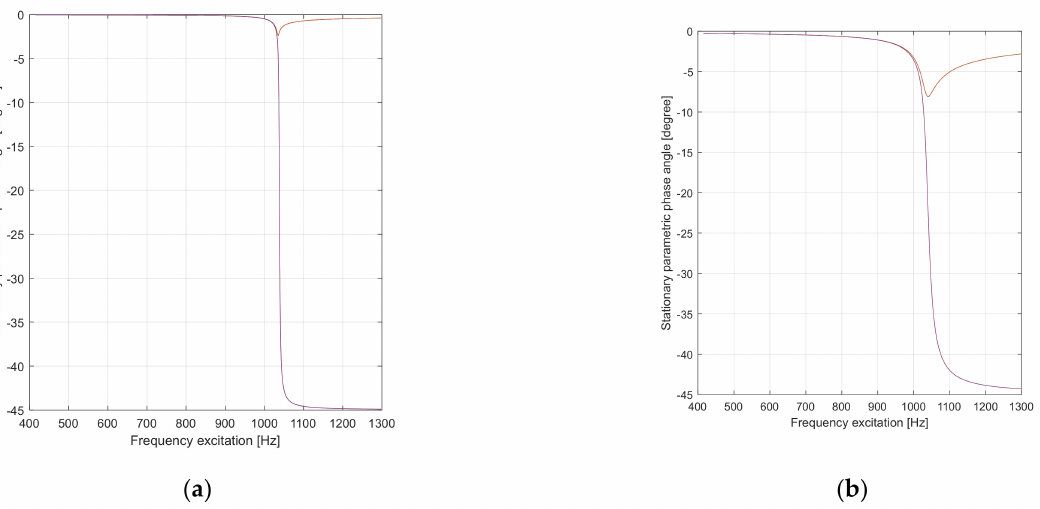
Figure 13. Stationary parametric phase angle Ψ of the tulip for χ nT = 0.25, where µ = 0.623 × 10 − 4 . ( a ) ζ = 0.0016. ( b ) ζ = 0.0116.